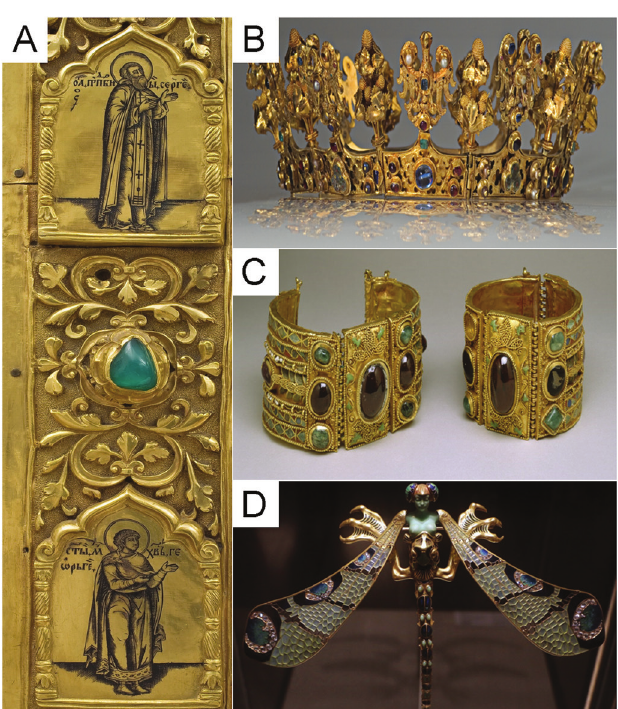
Figure 4. Chrysoprase in the world of art: A – element of the frame (left side) of the icon Holy Trinity by Andrei Rublev, irregular chryso- prase cabochon between the images of Blessed Sergey Radonezhsky and the martyr Georgyi. Trinity Lavra of St. Sergius in Sergiyev Posad, Russia; B – gothic female wedding crown (early XIVth c.) from the so-called “Środa Śląska Treasure” with 193 stones (almandines, py - ropes, pearls, sapphires, emeralds, and chrysoprase) set on the rim made of gold-silver alloy with copper admixture. National Museum in Wrocław, Poland. Inv. No. V-2333; C – pair of bracelets set with stones (garnet, amethyst, emerald, pearls, chrysoprase) as well as glass and enamel from a gold treasure found in Olbia (Ukraine), late 2nd / 1st century BC (Greco-Roman period), 5.3 x 7.9 cm. Walters Art Museum, Baltimore. Inv. No. 57.375-6; D – brooch “Dragon - fly-woman” (1897-98) (gold, chrysoprase, chalcedony, moonstones and diamonds, enamel). René Lalique collection. Calouste Gulbenki - an Museum, Lisbon, Portugal. Photo Sailko / Wikimedia Commons; Licence: CC BY